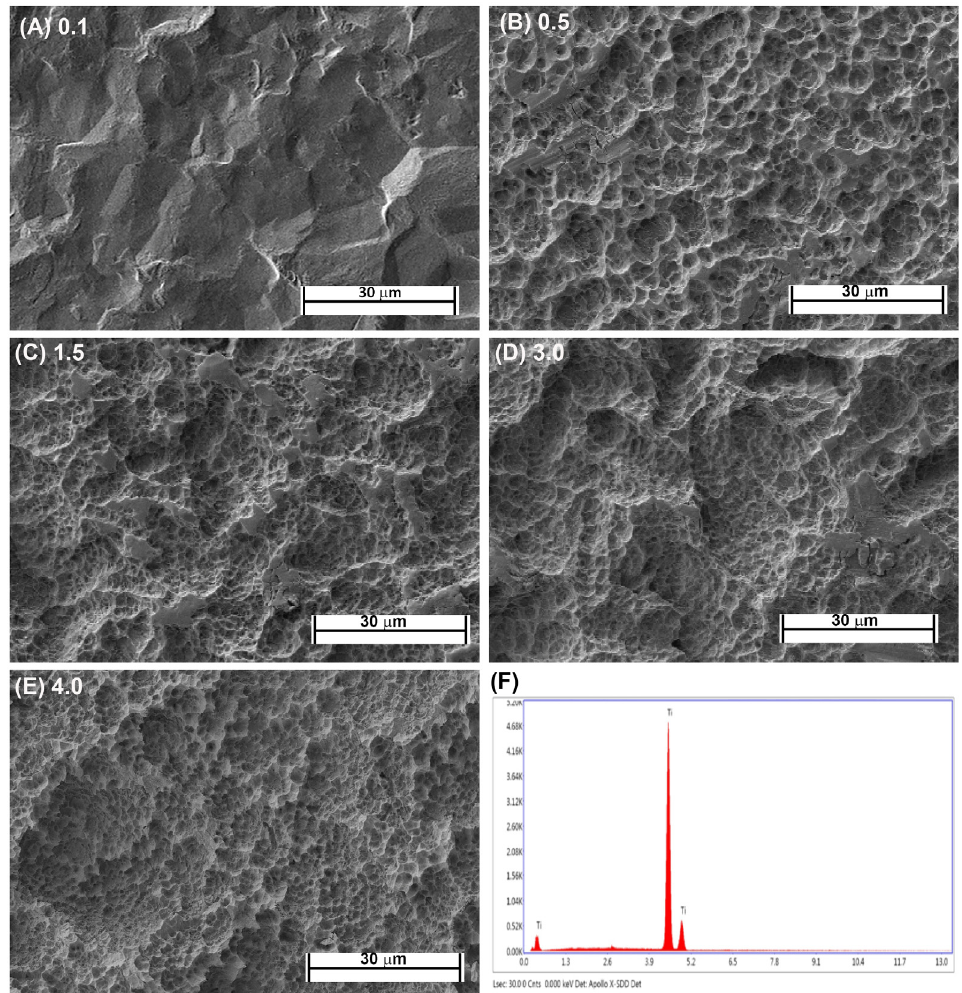
Figure 1. Characterization of titanium topographies used in the study. Scanning electron microscope images on ( A ) 0.1 (PT, Institut Straumann AG), ( B ) 0.5, ( C ) 1.5, ( D ), 3.0 and ( E ) 4.0 (SLA, Institut Straumann AG). In ( F ), XPS spectra is shown confirming surfaces are titanium oxide.